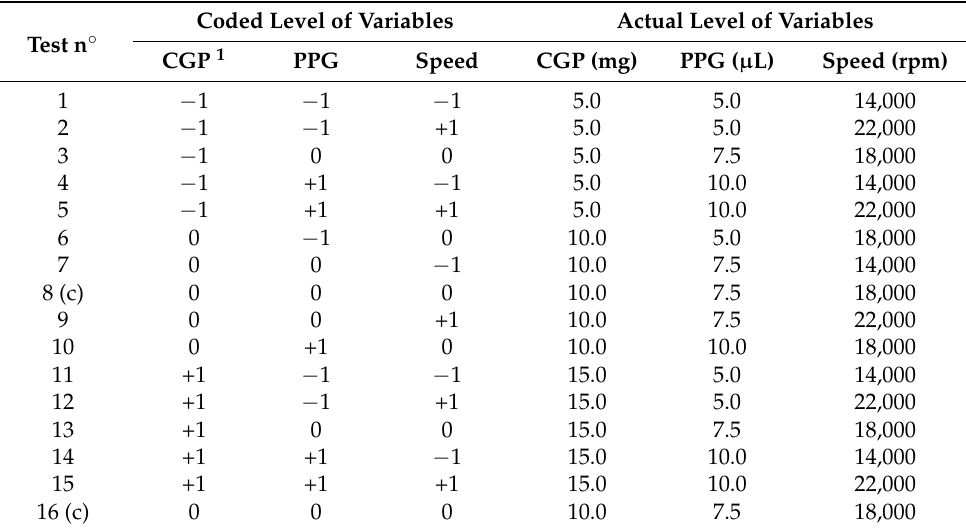
Table 1. Coded and actual levels of the variables used in the 2 3 central composite rotatable design (CCRD) to produce the CGP-PPG@diclofenac nanoparticles. Coded Level of Test n ◦